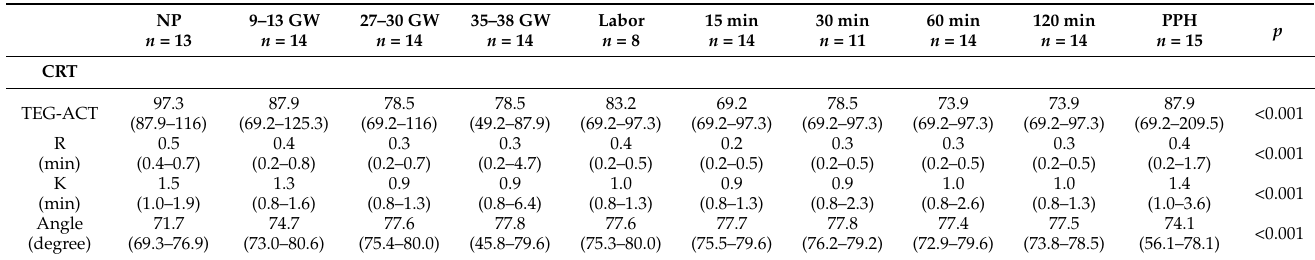
Table A1. The results of thromboelastographic parameters in CRT, CKH and CFF assay obtained with TEG6s ®